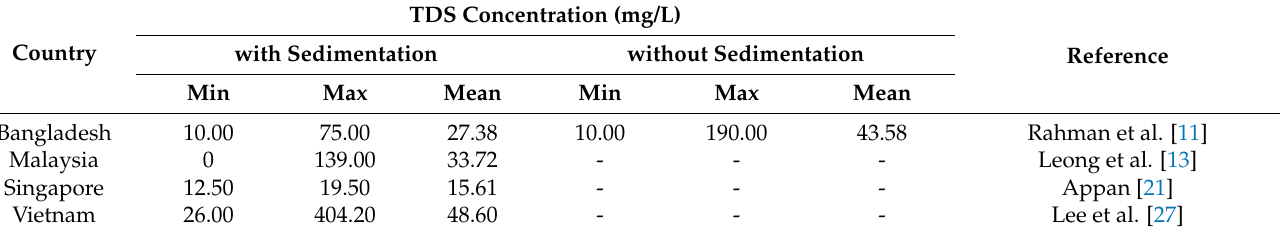
Table 4. Measurements on TDS concentration.